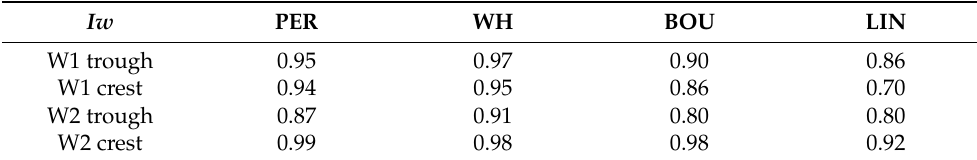
Table 2. Wilmott index for comparisons of the streamwise velocity trends shown in Figure 3.